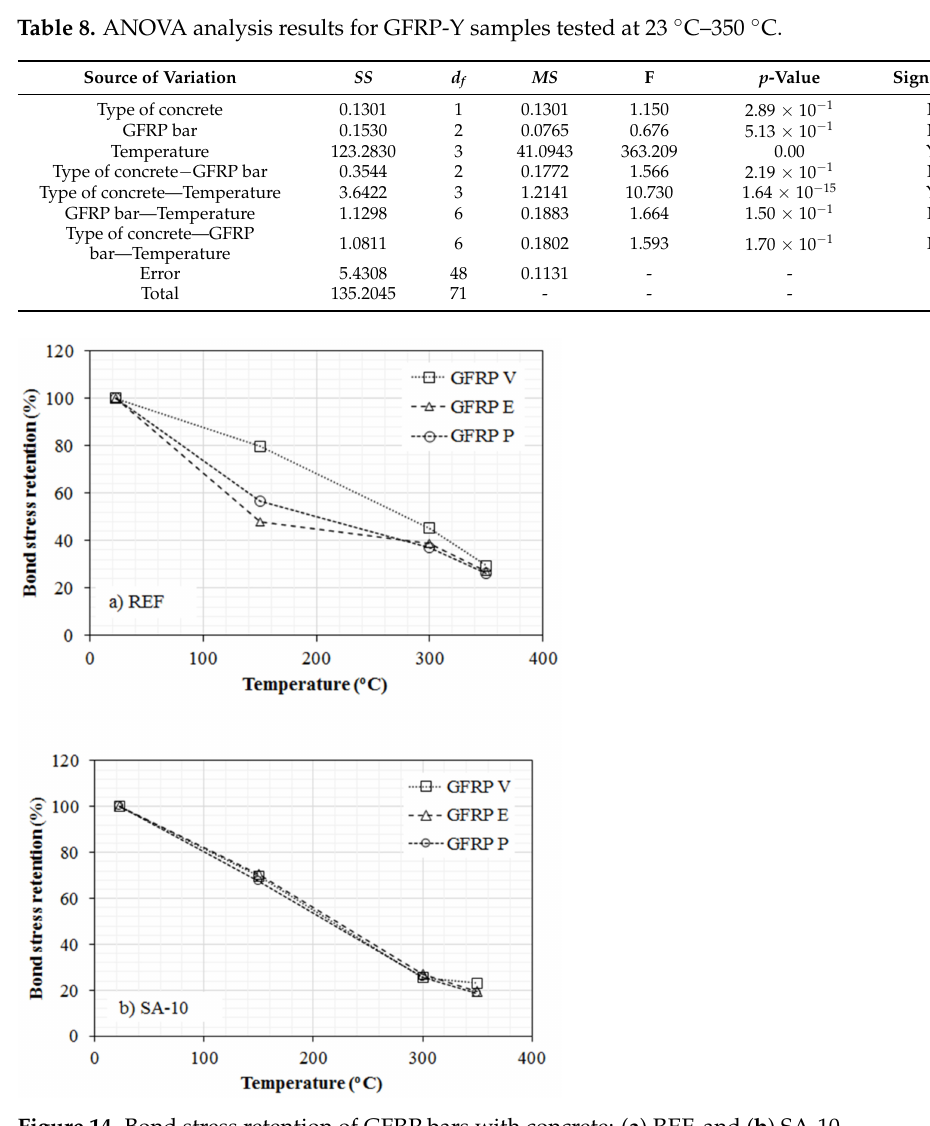
Figure 14. Bond stress retention of GFRP bars with concrete: ( a ) REF, and ( b )